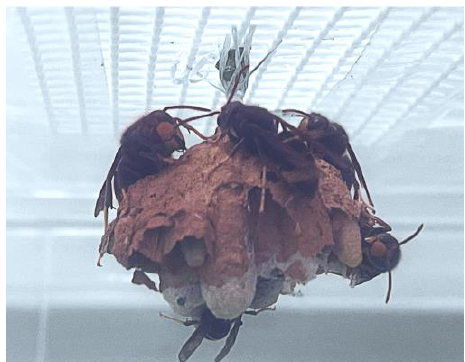
Figure 5. Vespa velutina female hornets fighting each other shortly after the nest was collected.